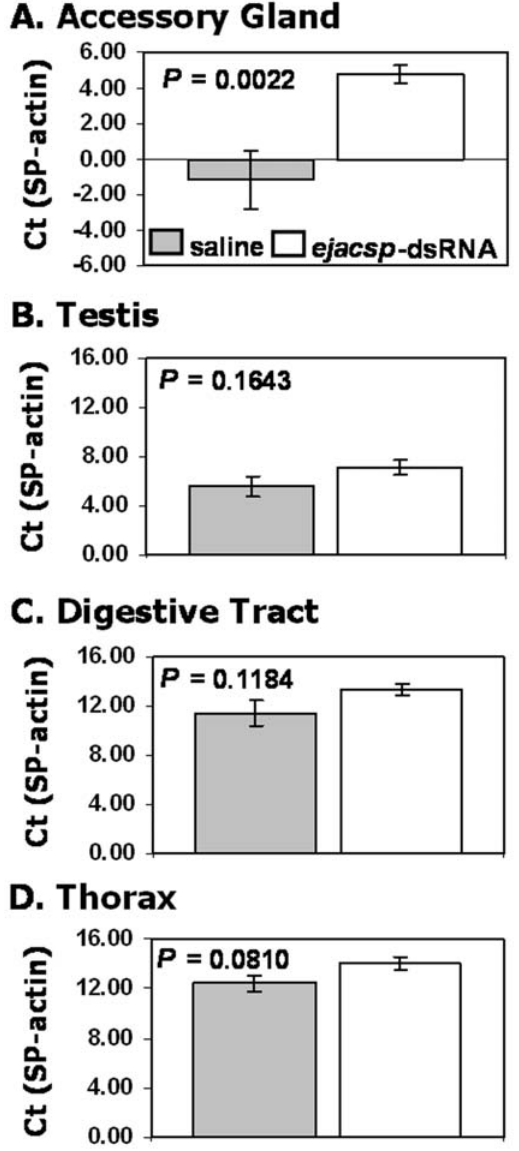
Figure 5. Real-time PCR of trypsin-like serine protease in each tissue for each injection treatment. The expression, as quantified by D Ct via qPCR, of trypsin-like serine protease relative to b -actin (the control gene) in the saline- and ejacsp -dsRNA-injected males (gray and open bars, respectively) for the male reproductive accessory gland (A), testis (B), digestive tract (C), and thorax (D). Significant knockdown only occurred in the male accessory gland. Sample size equals 11 in both treatments for all tissue